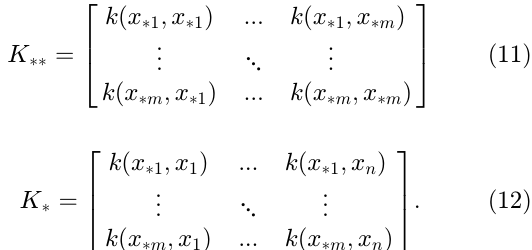
Fig. 1. Test apparatus of